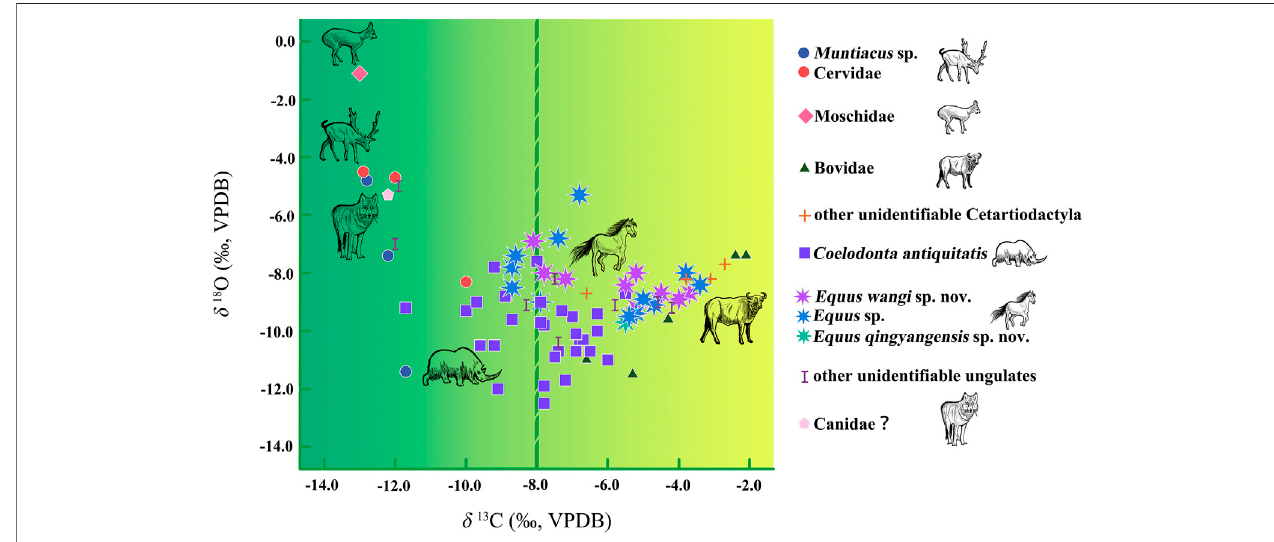
FIGURE 3 | δ 13 C and δ 18 C values of the MDG teeth